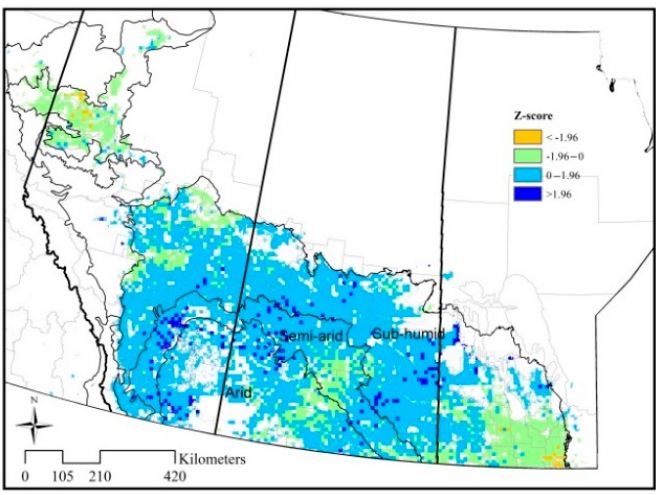
Figure 10. Spatial patterns of rainfall trends from 2000 to 2013 using the M–K z -score.